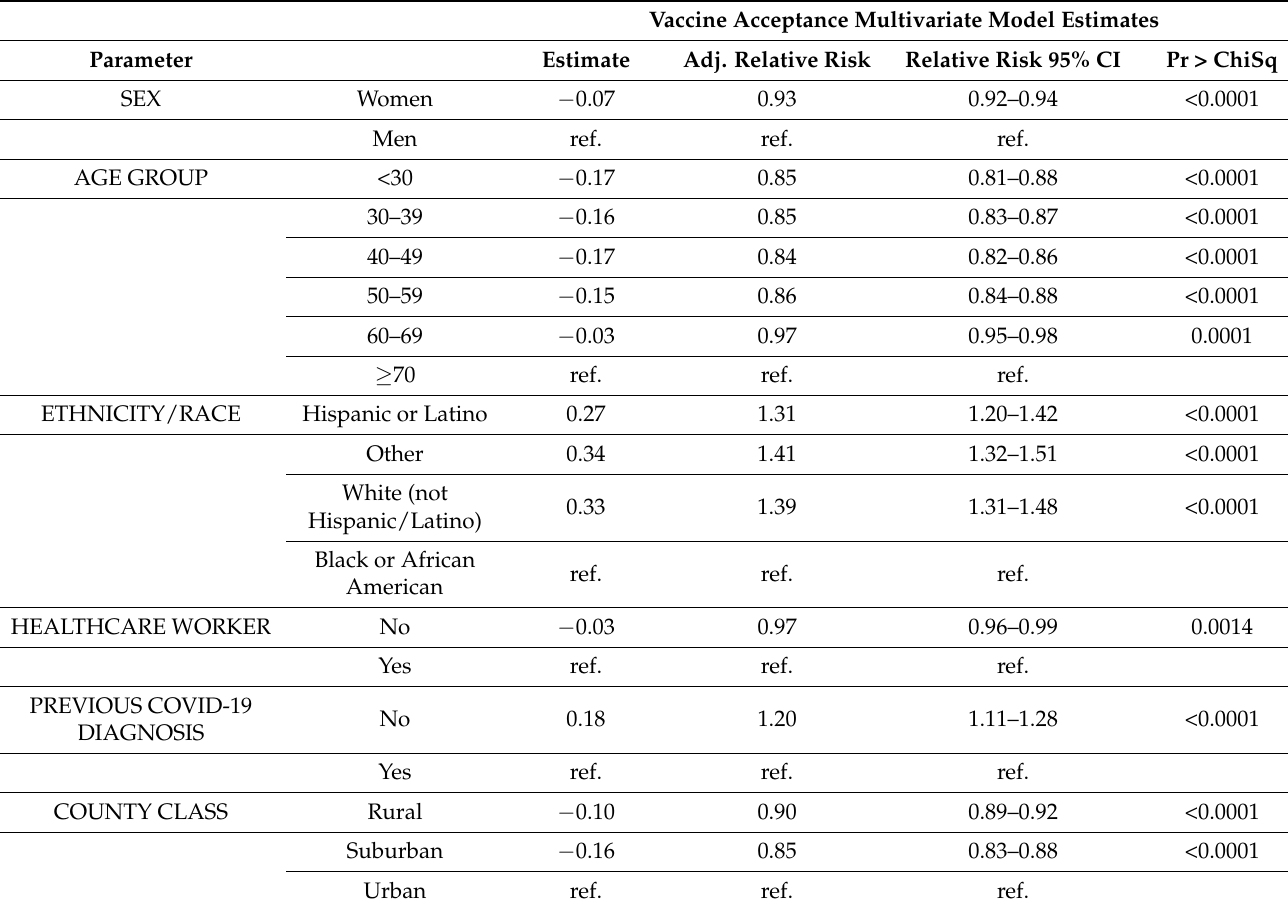
Table 4. Vaccine acceptance multivariate analysis grouped by sex, age, race & ethnicity, healthcare worker status, previous COVID-19 diagnosis, Site and county class. CI—Confidence interval; ChiSq—Chi square. Ref.—reference